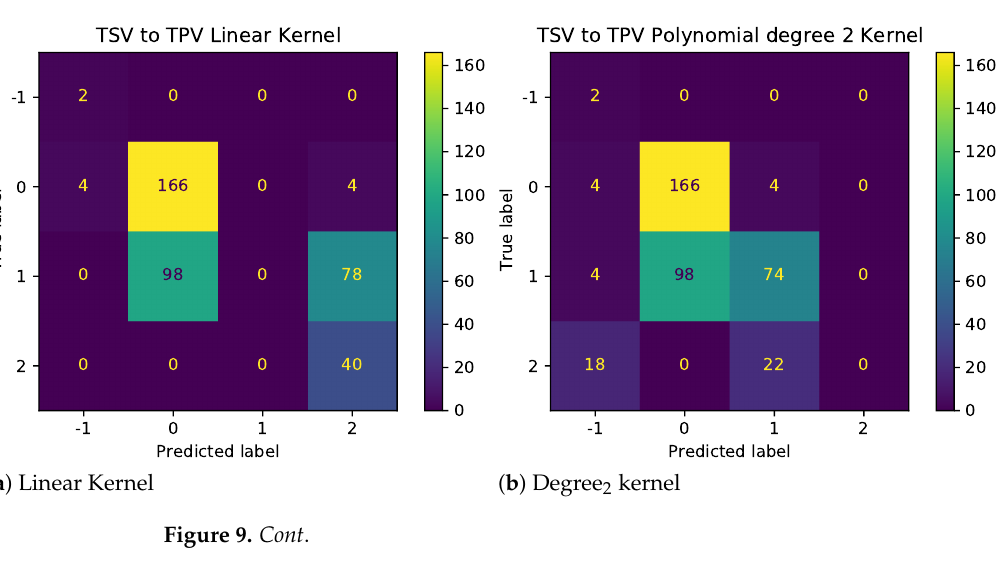
Figure 8. Confusion Matrix for different SVM Kernels with original primary student data.